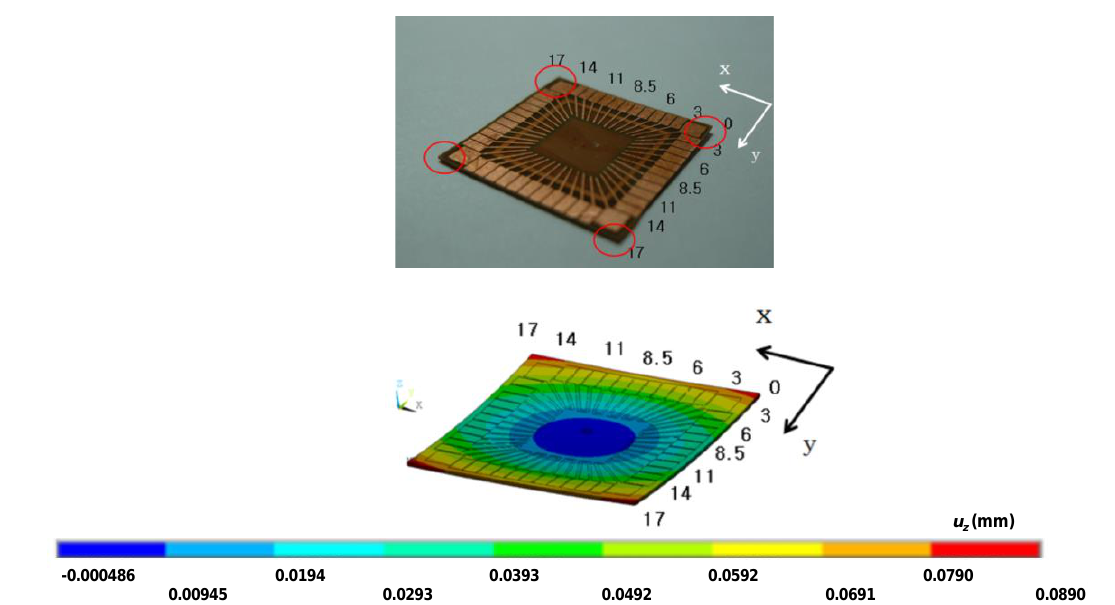
Figure 7. Application to a multilayer PWB case.